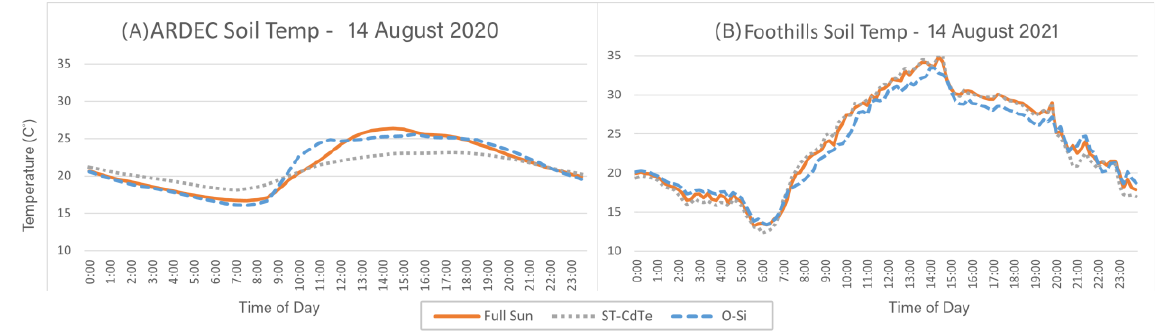
Figure 6. Soil Temperature at 2.5 cm depth (ARDEC, 2020, and Foothills, 2021).